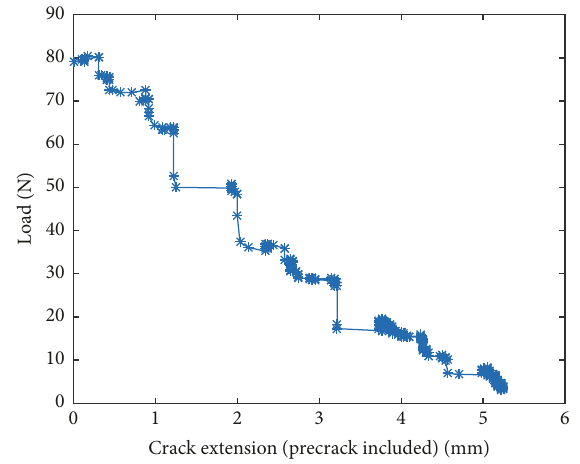
Figure 7: Load versus crack